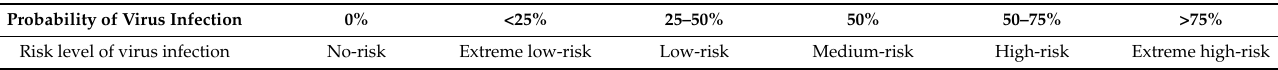
Table 2. The risk classification of virus